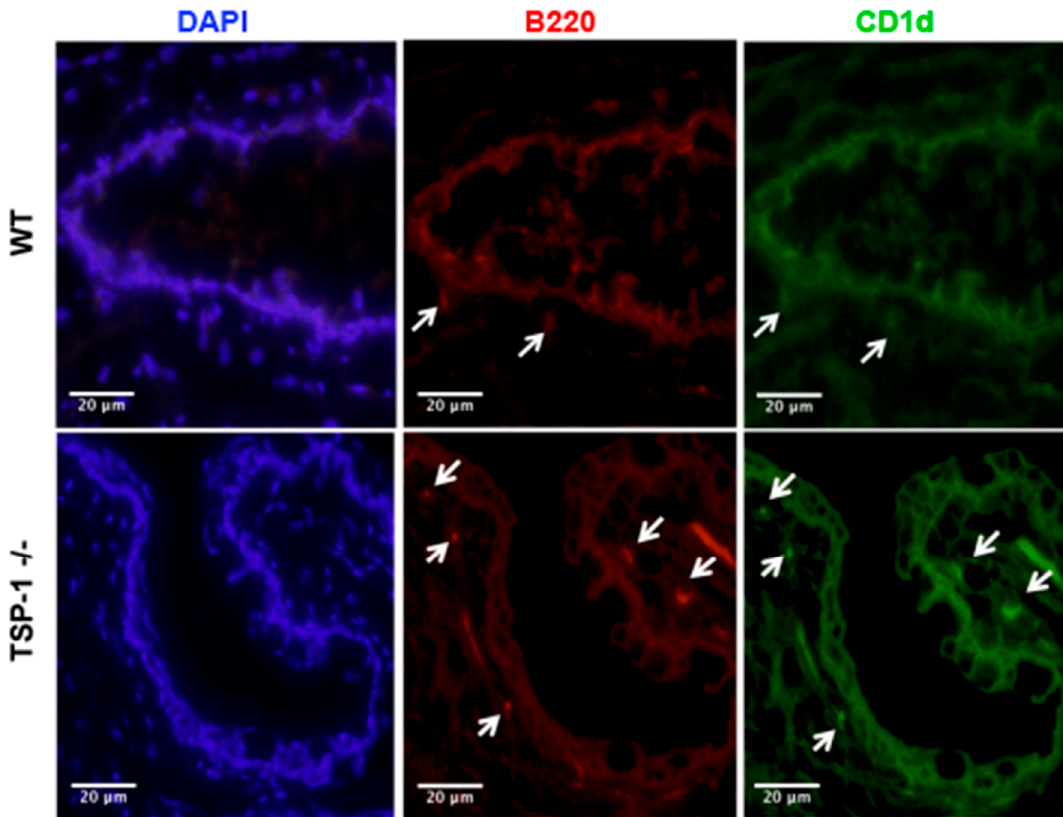
Figure 3. Detection of MZB cells in the conjunctiva (ocular mucosal tissue). Representative images of immunostained sections of conjunctiva from WT and TSP1 − / − mice (200 × ; scale bar, 20 µ m) are shown. Frozen tissue sections were stained for B220 (red) and CD1d (green). Nuclei were stained with DAPI (blue). Cells positive for both B220 and CD1d represent MZB cells and are marked with white arrows.